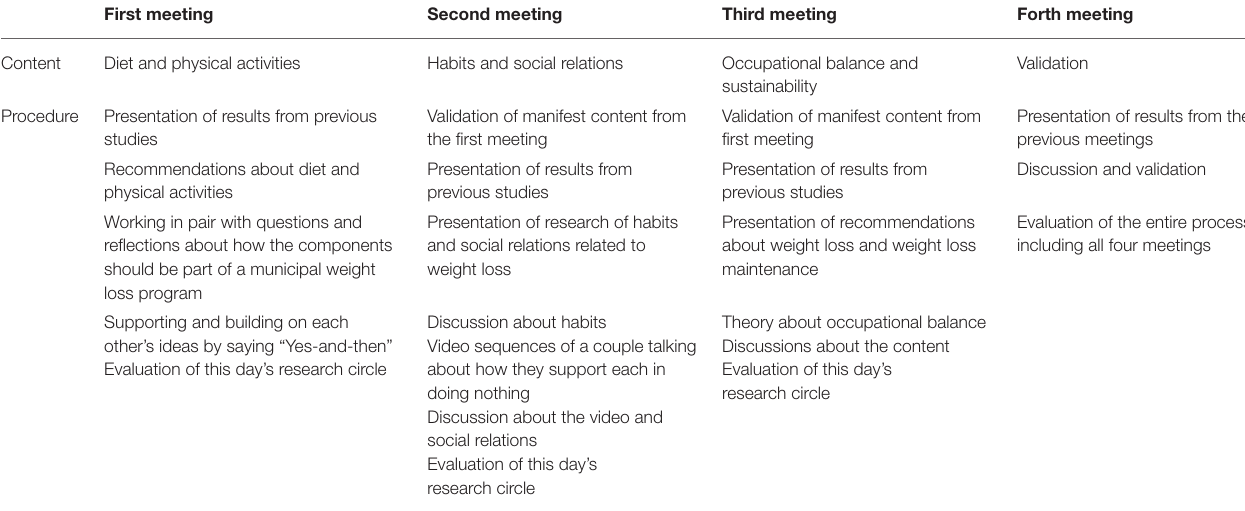
TABLE 1 | Procedure of the research